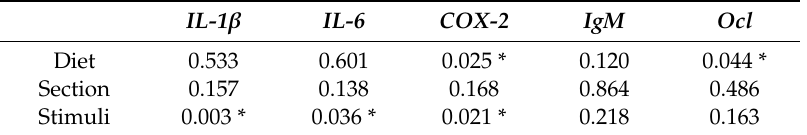
Table 1. E ff ect of di ff erent factors on normalized gene expression values in Phase II.